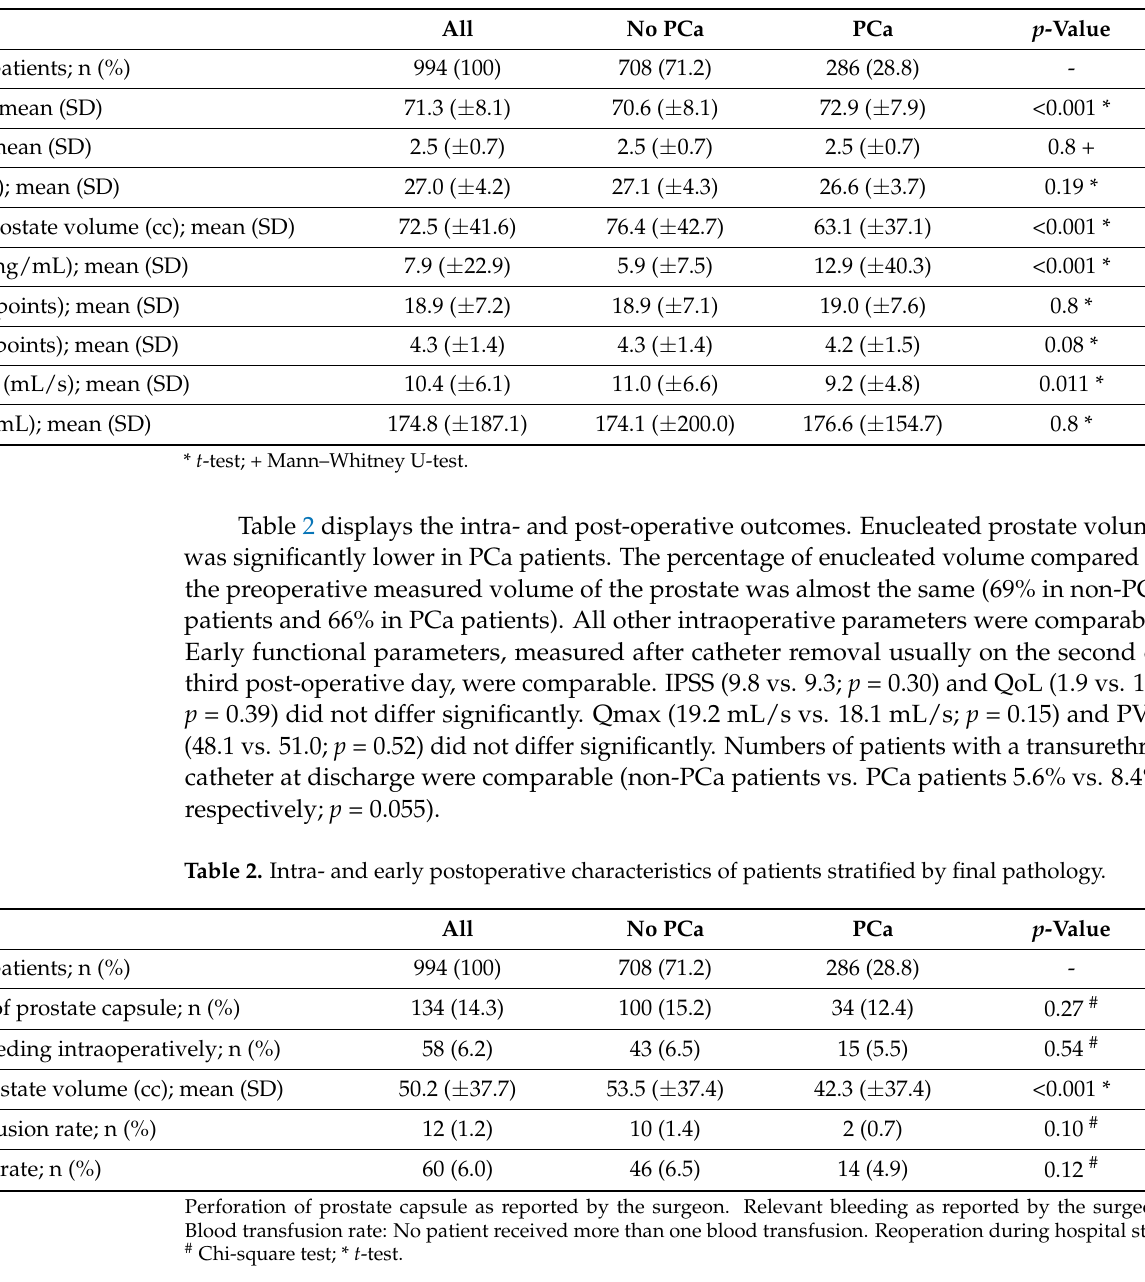
Table 1. Baseline and preoperative characteristics of patients stratified by final pathology.